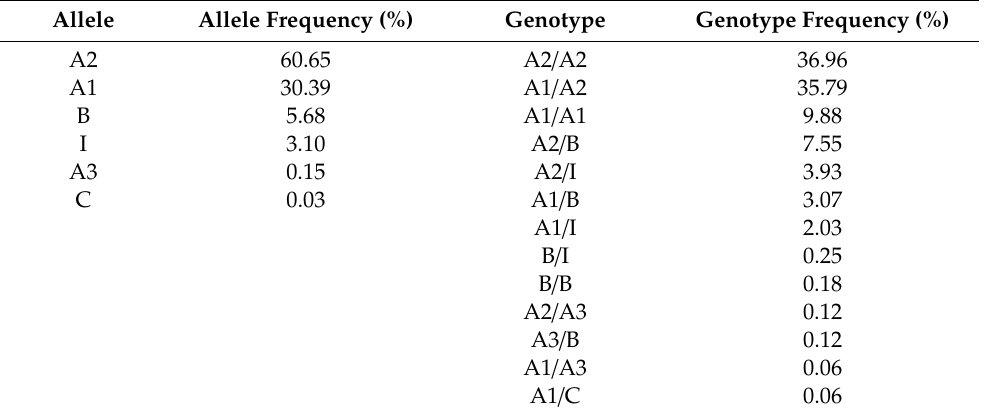
Table 3. The allele and genotype frequencies (%) in the examined animals (the data are sorted by decreasing allele and genotype